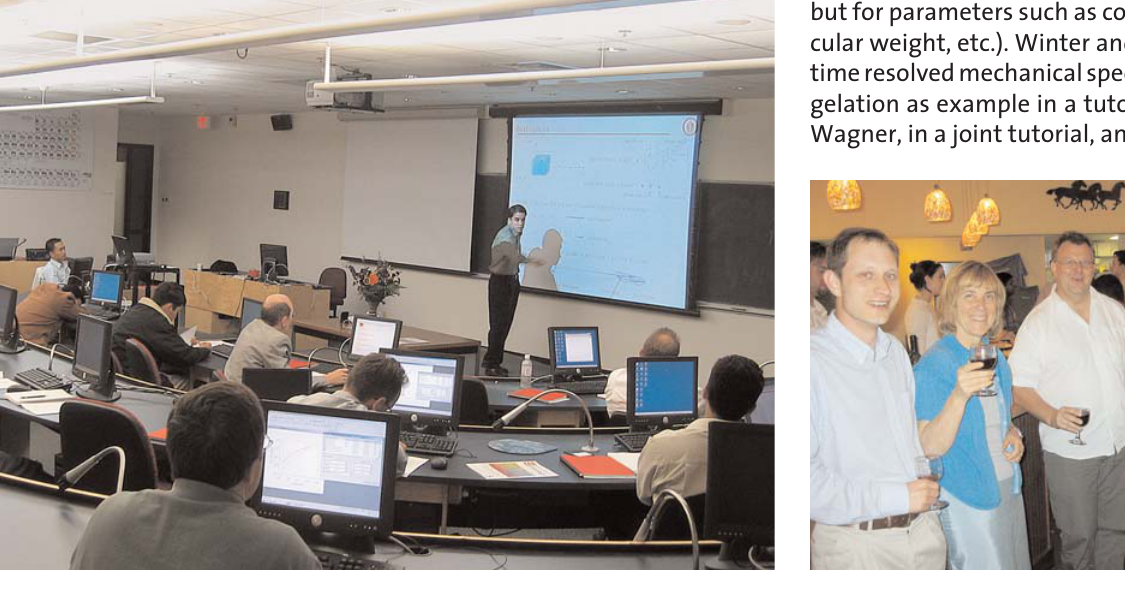
Figure 1 (left): Jonathan Rothstein lecturing. Figure 2 (right): Dinner after day